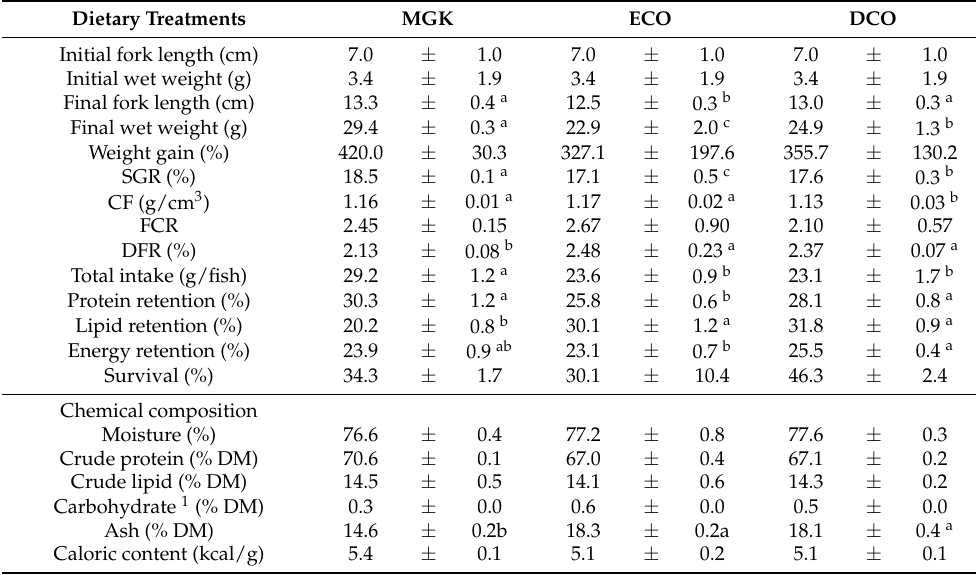
Table 3. Fish performance, feed utilisation and analysed proximate composition of juvenile ABT ( T. thynnus ) fed reference (MGK) and test (ECO and DCO) diets for 18 days. Dietary Treatments MGK ECO Initial fork length (cm)